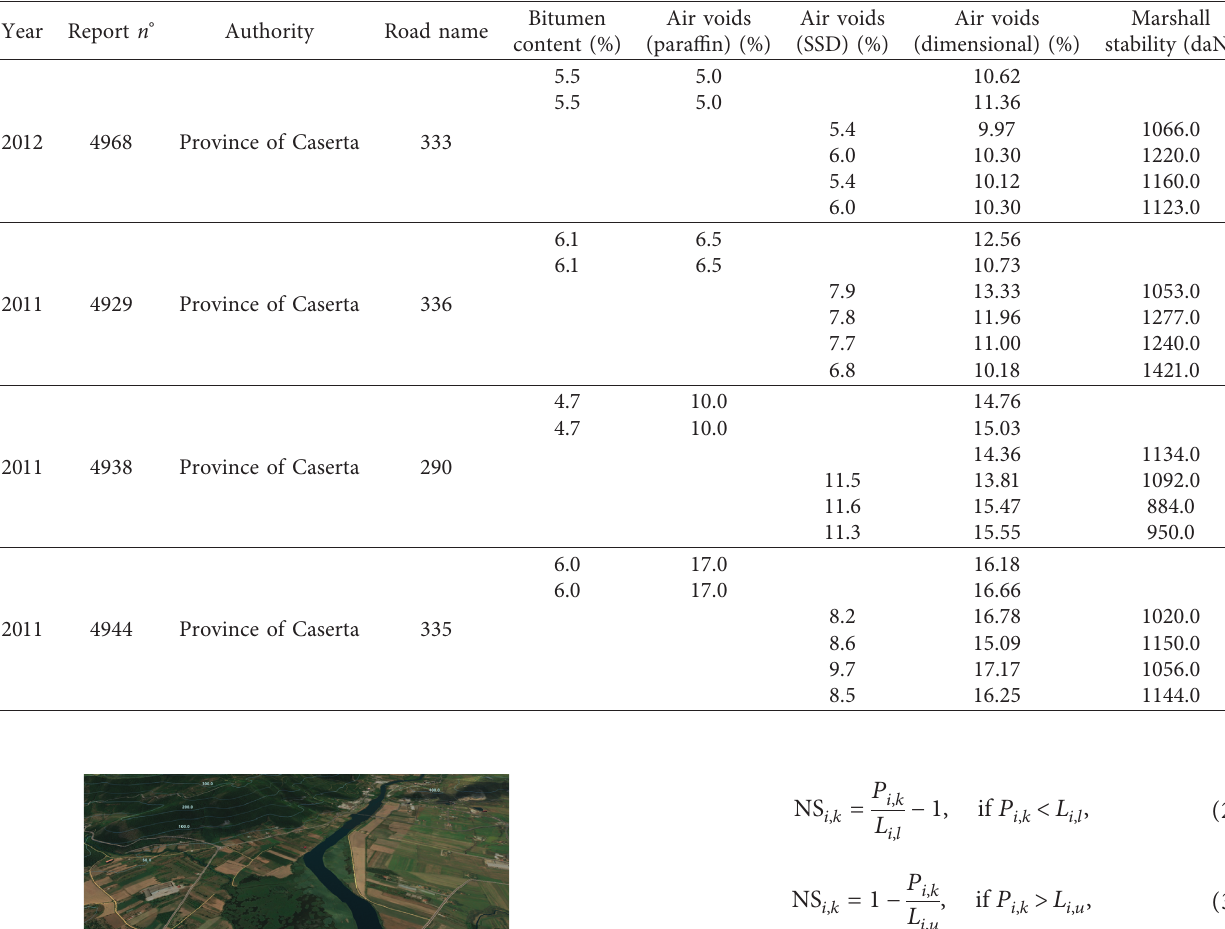
Table 1: Excerpt of the worksheet containing survey data of the road pavement materials.